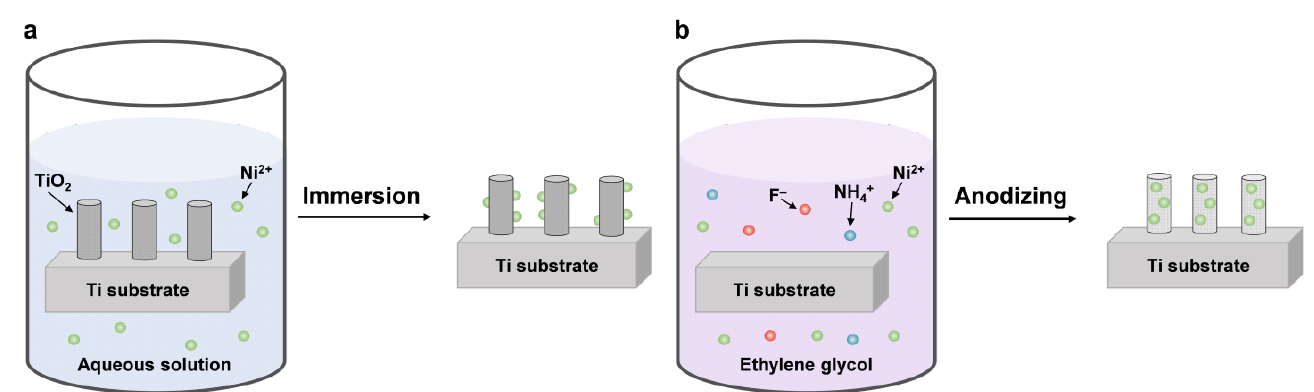
Figure 3. Schematics of Ni-doped TiO 2 formation by ( a ) immersion in an aqueous solution and ( b ) anodizing ethylene